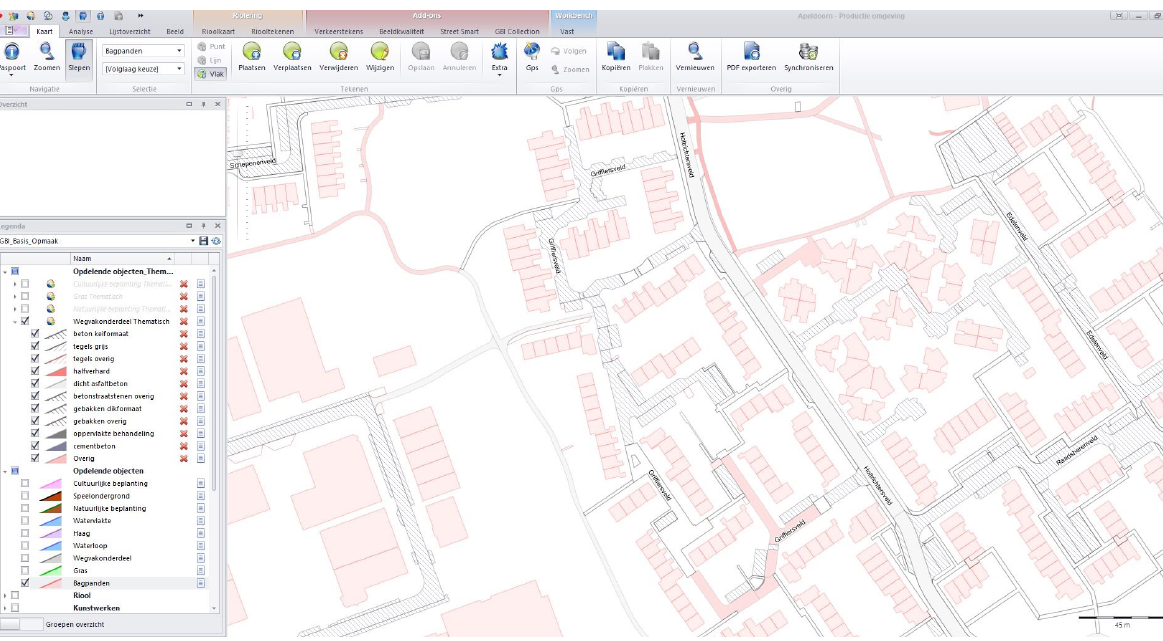
Figure 1. Screenshot of the GBI asset management system showing Griffiersveld in